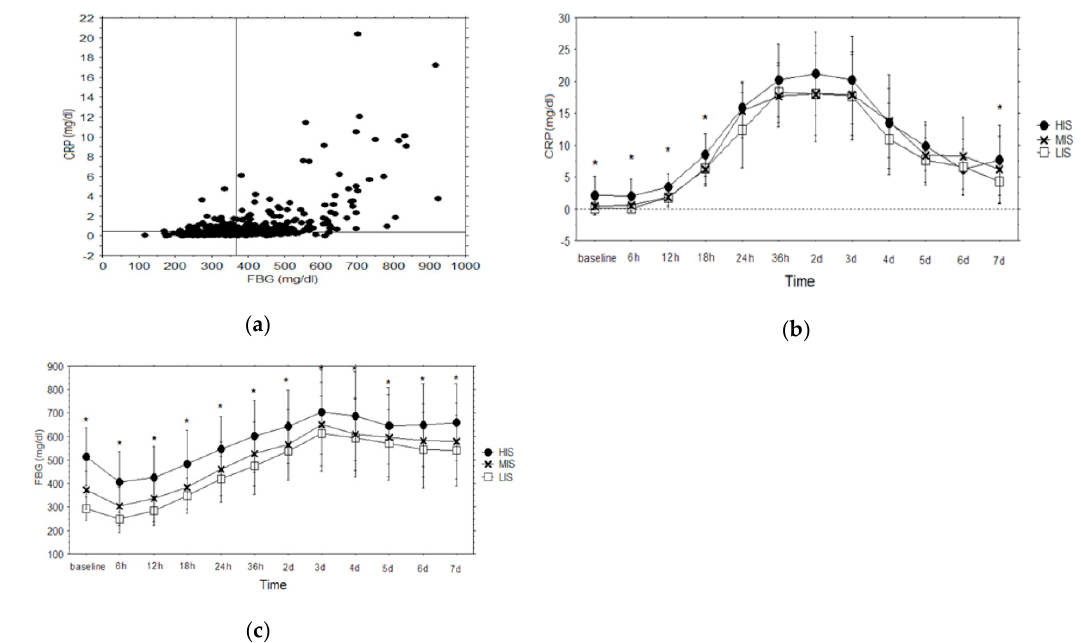
Figure 1. ( a ) A scattergram of preoperative C-reactive protein (CRP) and Fibrinogen (FBG) plasma levels of 470 patients who had undergone cardiac surgery. The two lines which cross the box represent the median values of CRP (0.39 mg/dL) and FBG (366 mg/dL). ( b ) Perioperative values of C-reactive protein (CRP) in the low inflammatory group (LIS), medium inflammatory group (MIS) and high inflammatory group (HIS). The asterisks mark differences with p ≤ 0.05. ( c ) Perioperative values of fibrinogen (FBG) in the low inflammatory group (LIS), medium inflammatory group (MIS) and high inflammatory group (HIS). The asterisks mark differences with p ≤ 0.05.